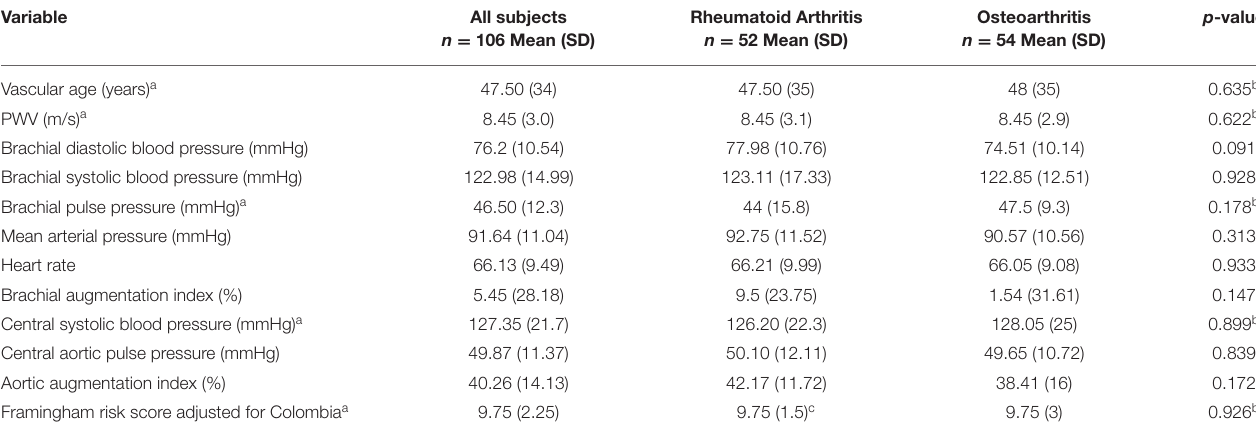
TABLE 3 | Cardiovascular variables.